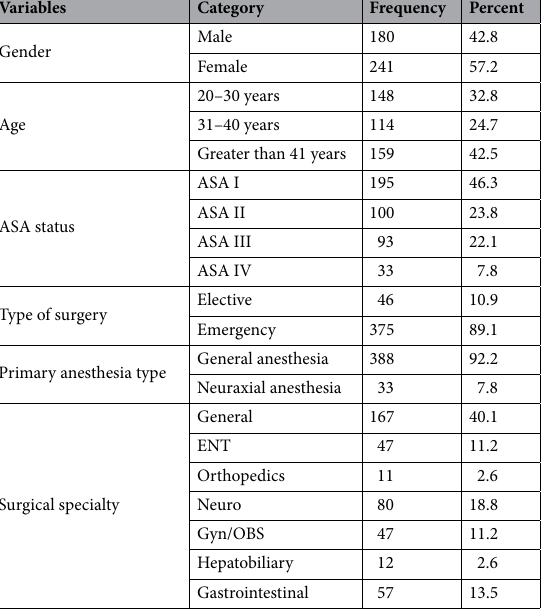
Table 1. Characteristic of patient admitted to intensive care unit following surgery,